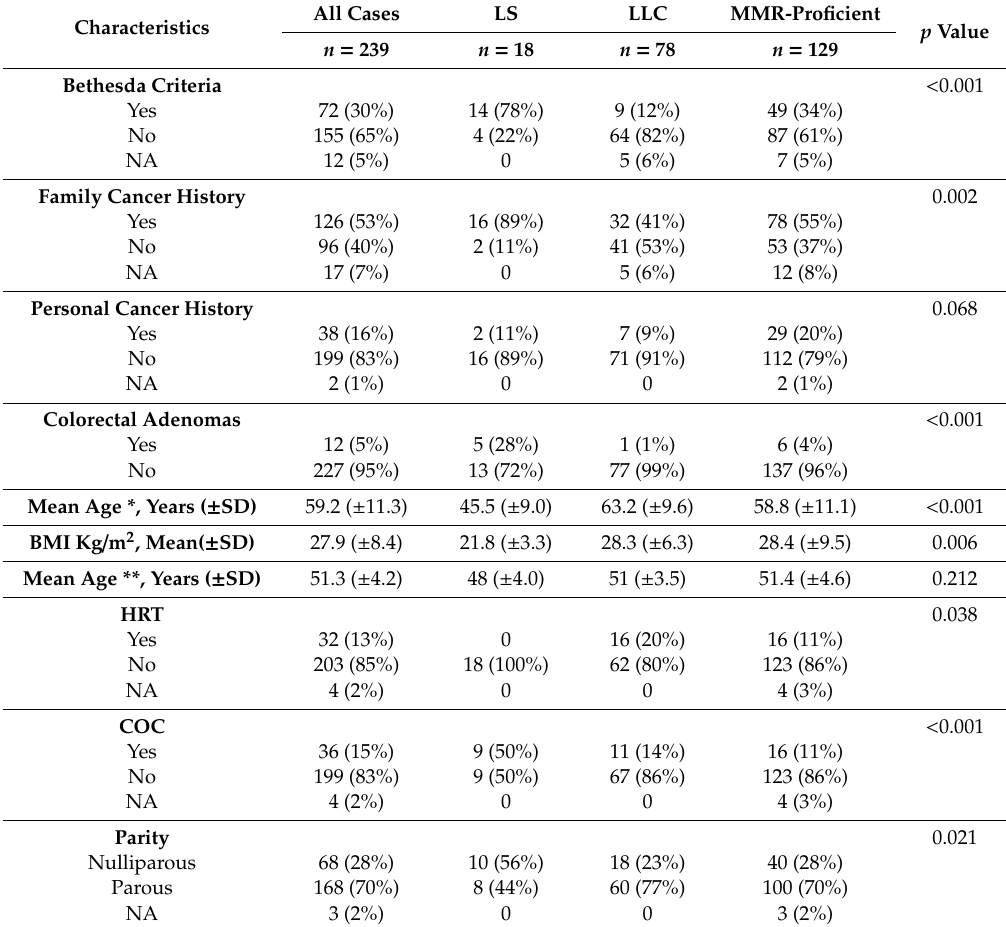
Table 2. Personal and familial oncological history of cancer and clinical data in the three groups study.